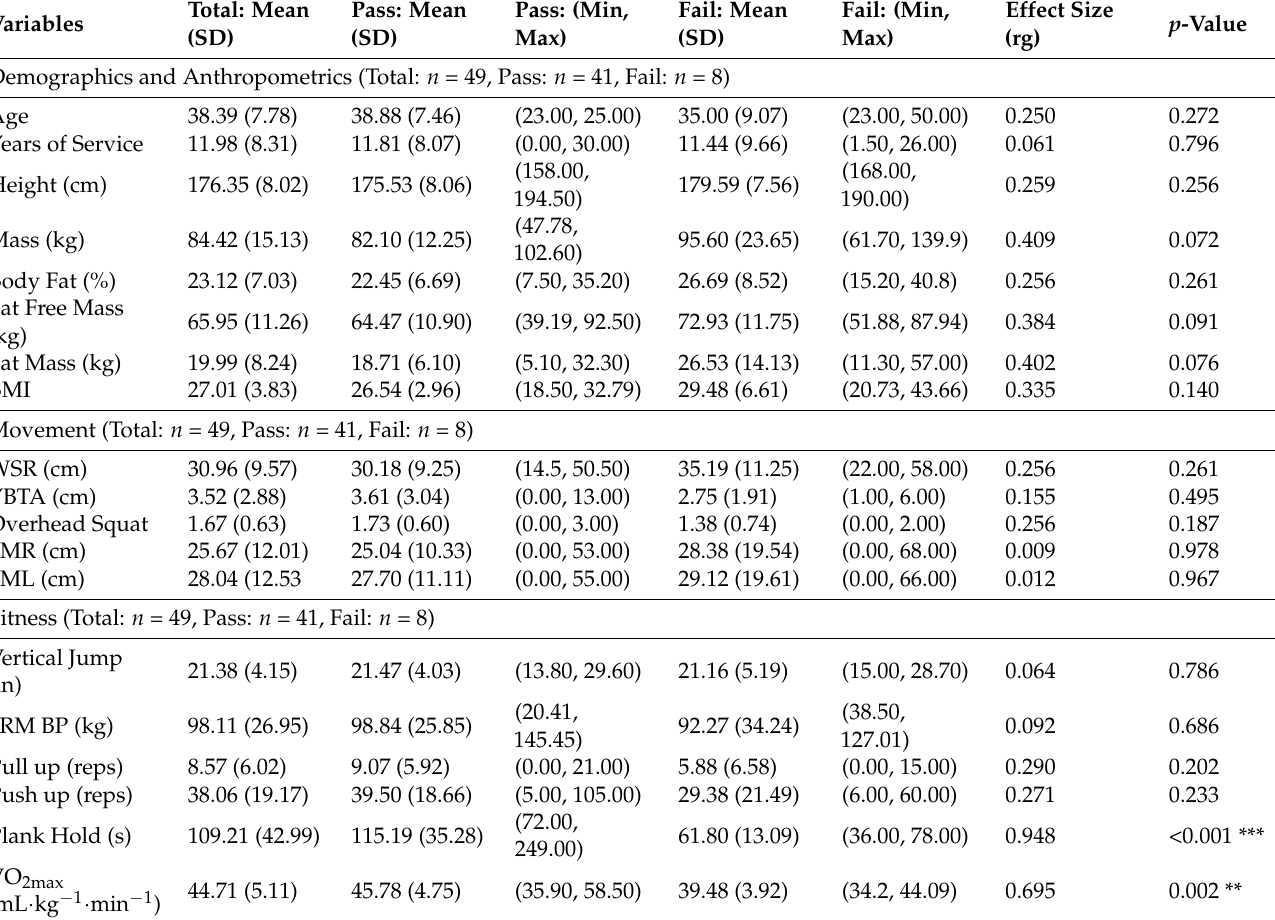
Table 1. Demographic, fitness, lifestyle, and personality characteristics of the tactical